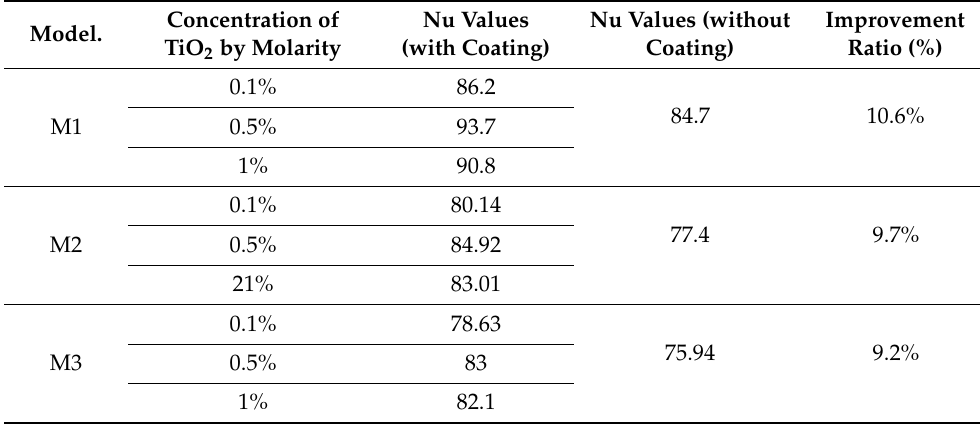
Table 5. Improvement ratio of TiO 2 nanocoating surface plate.